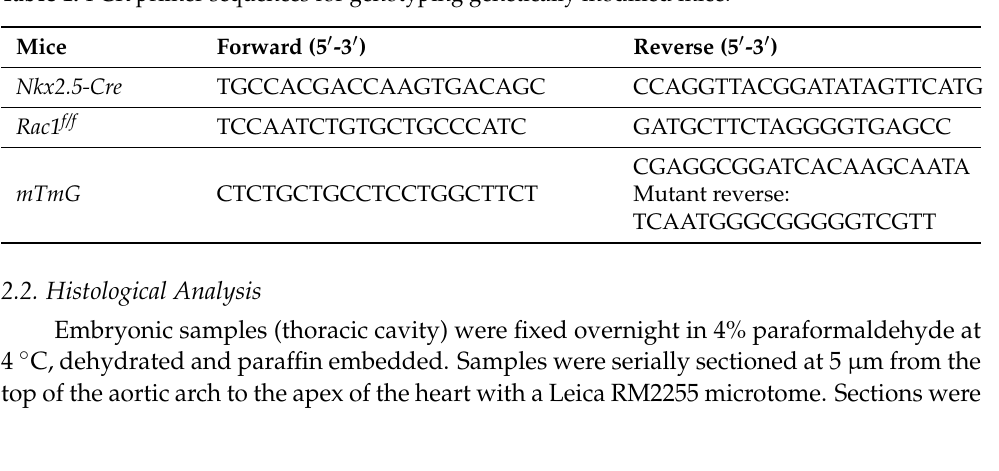
Table 1. PCR primer sequences for genotyping genetically modified